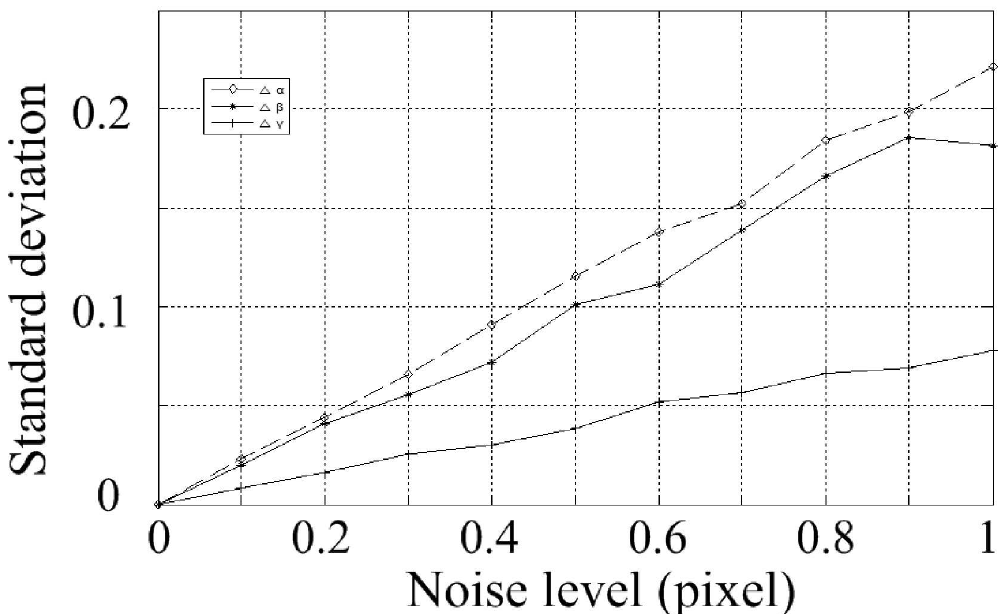
Fig 7. Standard deviations for parameters α , β , γ .